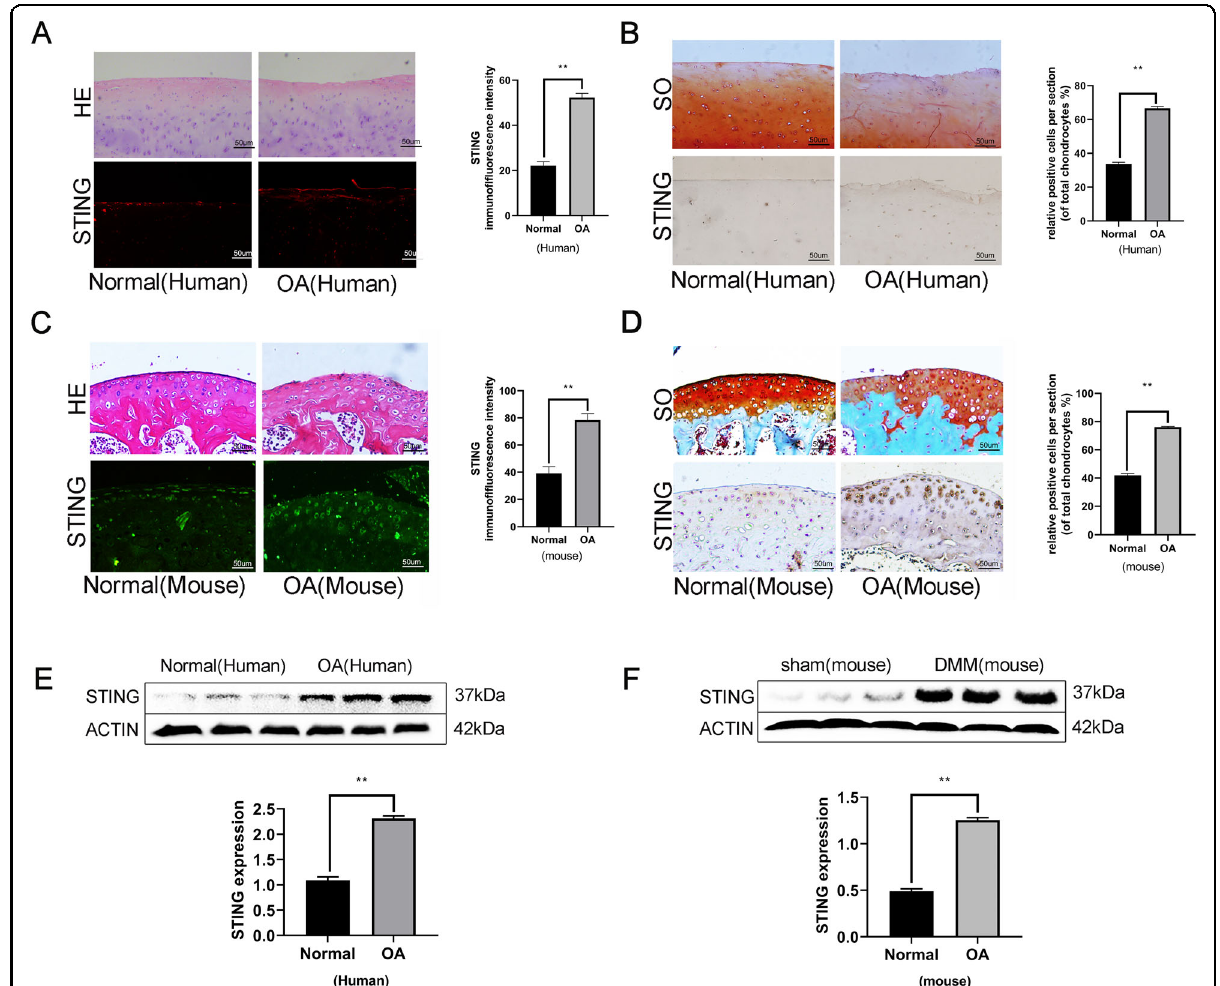
Fig. 1 The expression of STING is increased in osteoarthritic human and mouse articular cartilage. A – B Representative H&E staining, Safranin O staining as well as immuno fl uorescence staining, immunohistochemistry staining in human articular cartilage from normal, as well as OA patients (bar: 50 μ m). C – D Representative H&E staining, Safranin O staining, as well as immuno fl uorescence staining, immunohistochemical staining in mouse knee articular cartilage from sham, as well as DMM models (bar: 50 μ m). E The protein expression of STING in chondrocytes originated from normal and degenerated specimens of human. F The protein expression of STING in chondrocytes originated from normal group and DMM (degenerated) specimens of mouse. All data are indicated as the mean ± SD ( n = 5); ** P <